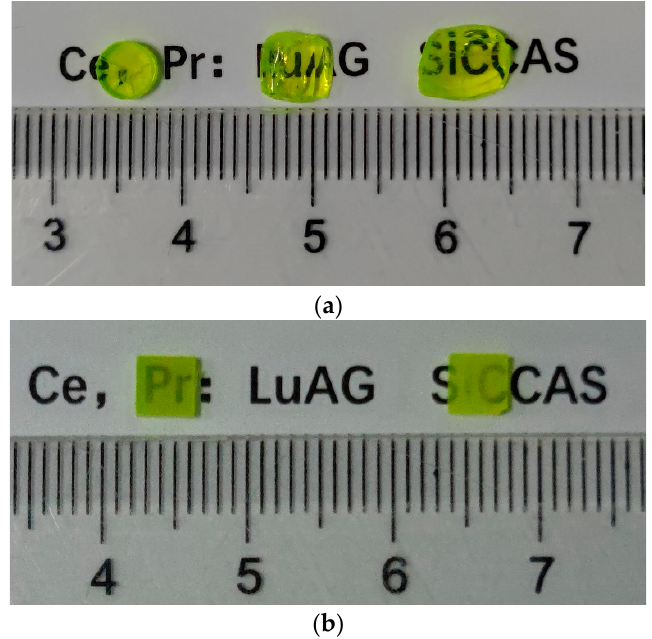
Figure 1. ( a ) Photograph of the Ce, Pr:LuAG crystals, as grown, with air annealing 1000 °C—5 h, 1000 °C—10 h from left to right, respectively (2.0 mm thickness) and ( b ) unannealed (left) and annealed (right) Ce, Pr:LuAG ceramics (1.2 mm thickness).